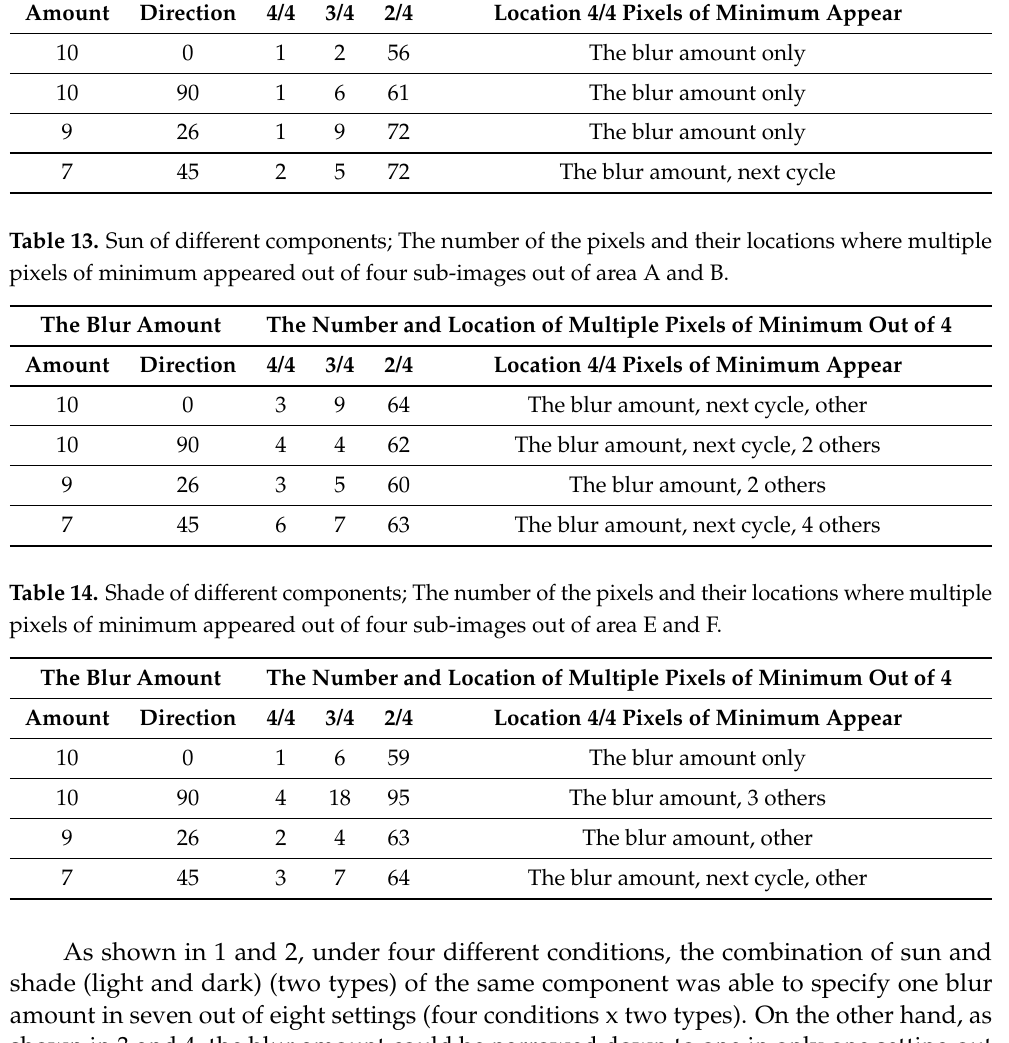
Table 12. Sun and shade; The number of the pixels and their locations where multiple pixels of minimum appeared out of four sub-images out of area B and F. The Blur Amount The Number and Location of Multiple Pixels of Minimum Out of 4